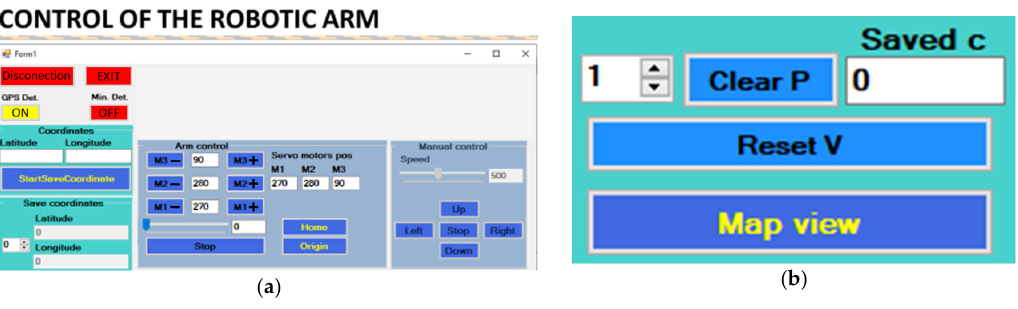
Figure 8. User control interface and the saving tool for coordinates: ( a ) general view; ( b ) reset button.